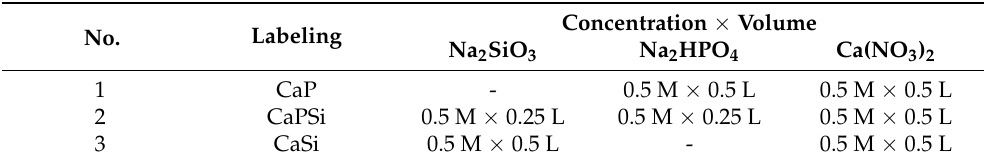
Table 1. Conditions used for the syntheses of powders from aqueous solutions Na 2 SiO 3 , Na 2 HPO 4 , and Ca(NO 3 ) 2